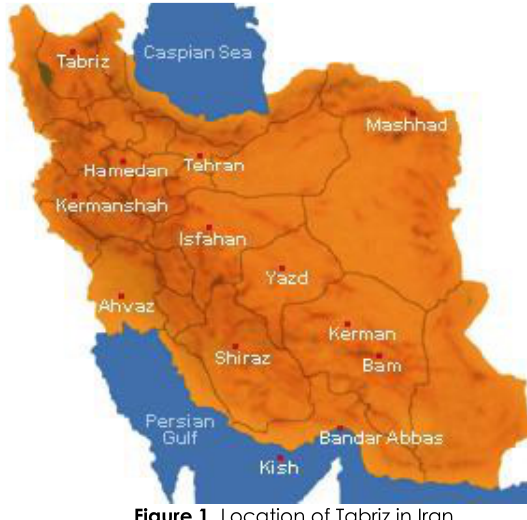
Figure 1. Location of Tabriz in Iran